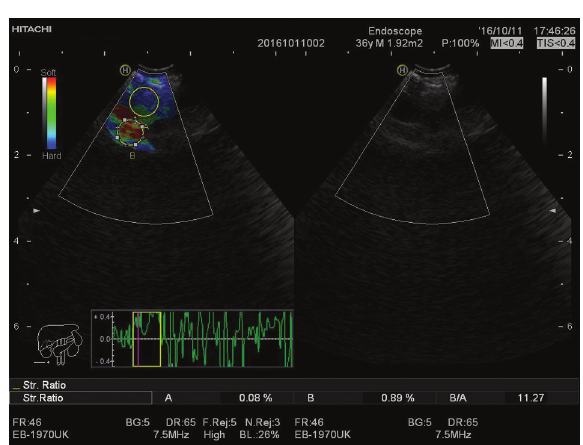
The elastography strain ratio measured the strain of the region of interest (the upper circle) compared with the normal surrounding tissue (lower circle) of similar size as a quantitative figure (strain ratio is 31.2)